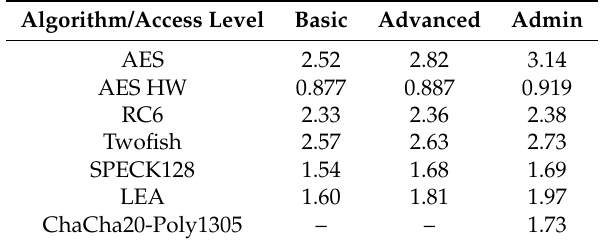
Table 5. Battery drain (mAh) in the ARMv8-a Xiaomi device. Algorithm/Access